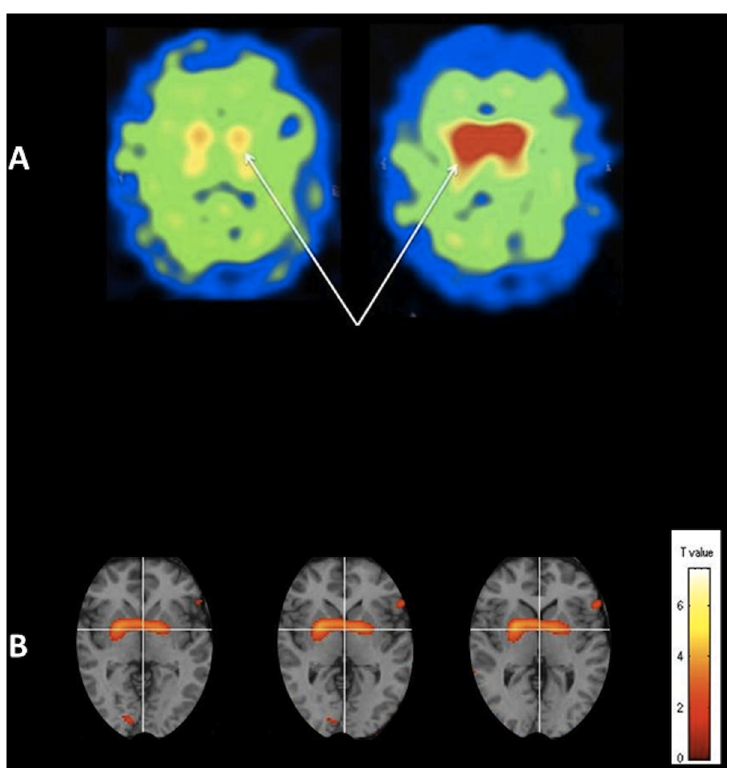
Fig 3. Pre and post NAC DaTscans (left and right respectively) from one particularly responsive patient (A) shows a substantial increase in dopamine transporter binding in the basal ganglia (arrows). We also present (B) the paired t test results overlaid onto a standard MRI template using SPM8 software showing significantly greater binding (p < 0.05) post NAC in the basal ganglia.